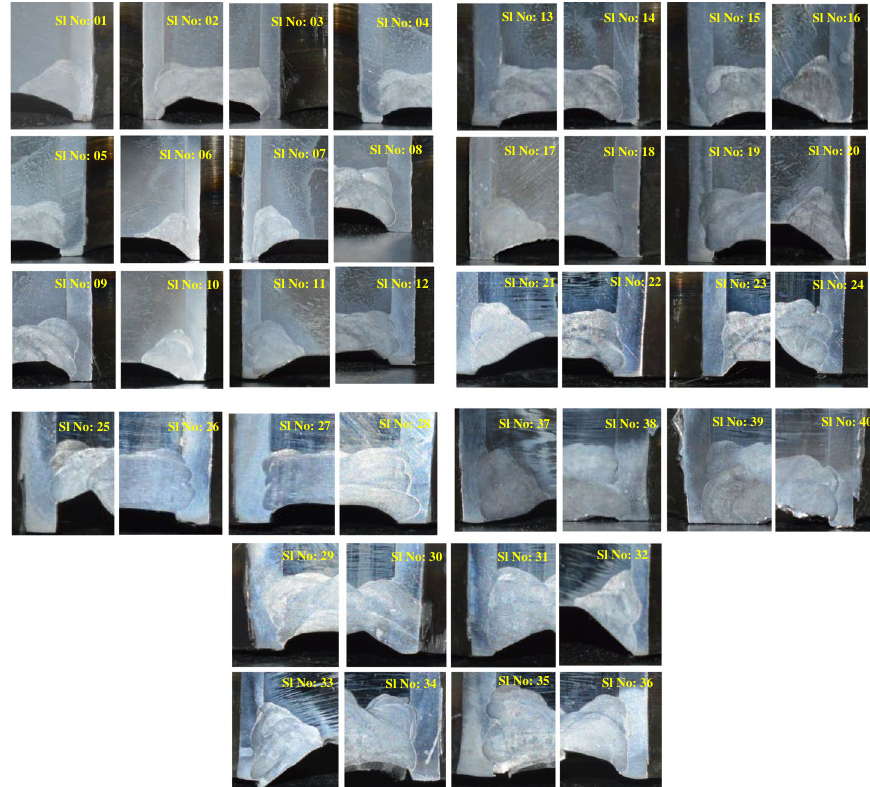
Fig. 4 Mechanical analysis (macro examination) for P